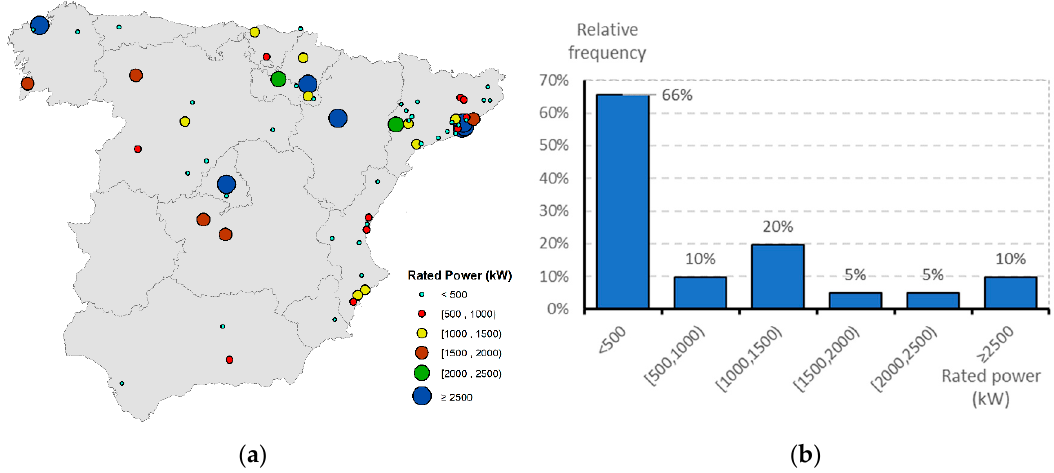
Figure 1. ( a ) Geographical distribution and its rated power of the currently installed digestion-based power plants in Spain. ( b ) Relative frequency of the rated power (data from [8]).